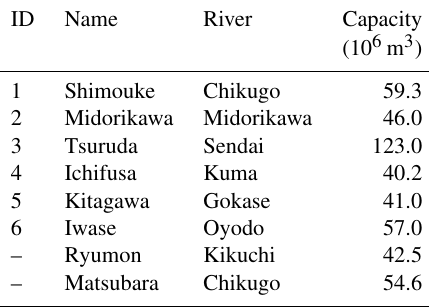
Table 2. Major dams along the rivers included in this study. We excluded the Ryumon Dam due to a lack of historical observation data. We excluded the Matsubara Dam because it is located just below the Shimouke Dam, complicating its use for